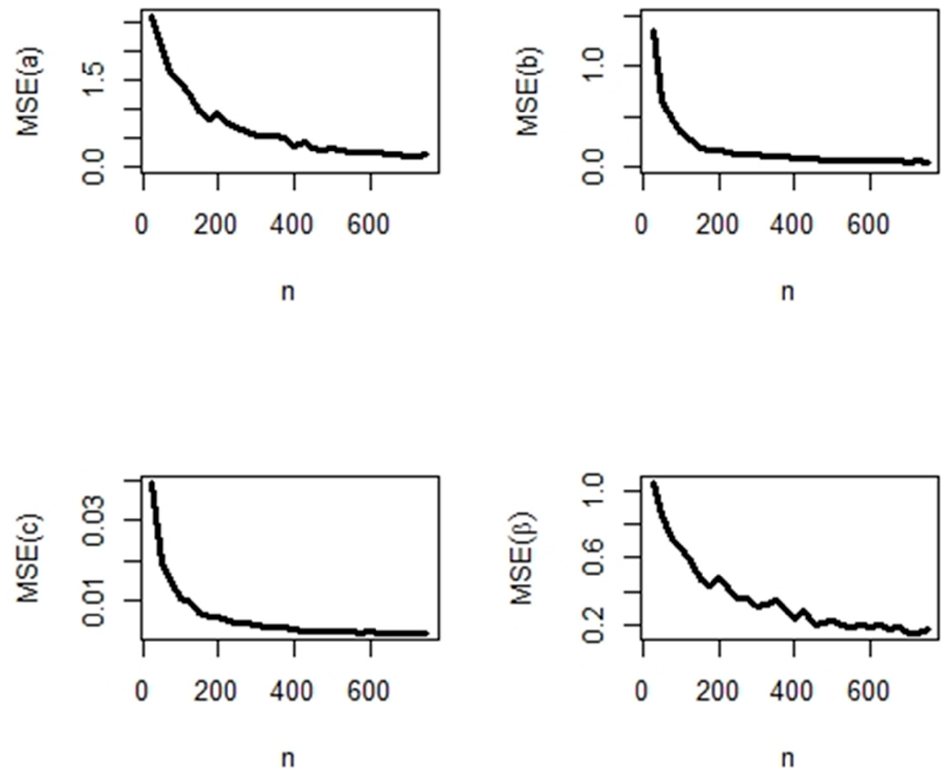
Figure 4. The MSEs of the estimates of parameters of the GOLE-W distribution.